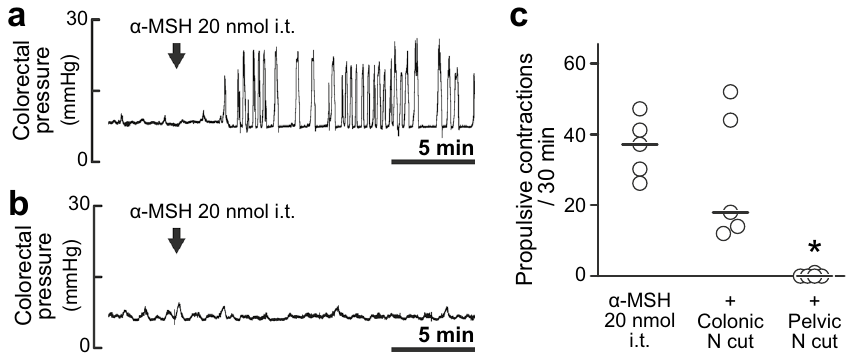
Figure 4. Neural pathways from the spinal defaecation centre to the colorectum. ( a , b ) Typical traces of colorectal pressure with α-MSH (20 nmol, i.t) in rats in which the colonic nerves ( a ) or the pelvic nerves ( b ) were severed. Severing the pelvic nerves prevented the prokinetic action of α-MSH (20 nmol), whereas severing the lumbar colonic nerves had no effect. ( c ) Summarised graph of number of propulsive contractions during a period of 30 min after α-MSH i.t. (20 nmol) in control (left), colonic nerve-severed (middle) and pelvic nerve-severed rats (right). The number of propulsive contractions induced by α-MSH (20 nmol, i.t.) in rats in which the pelvic nerves were severed significantly decreased compared to that in the control group. Each open circle ( ○ ) indicates a result from an individual rat, and the black bar shows the median. *Denotes a significant difference from the control group ( P < 0.05). Five rats were used in each